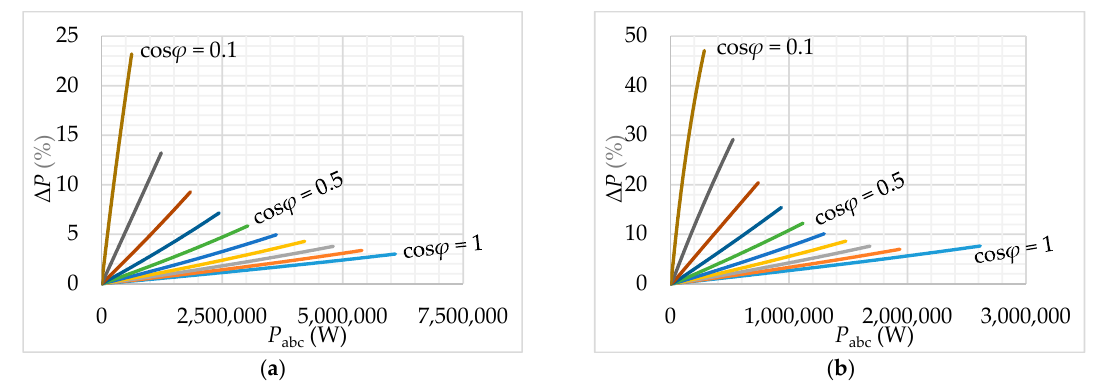
42/7: ( a ) the length of 5 km; ( b ) the length of 30 km.